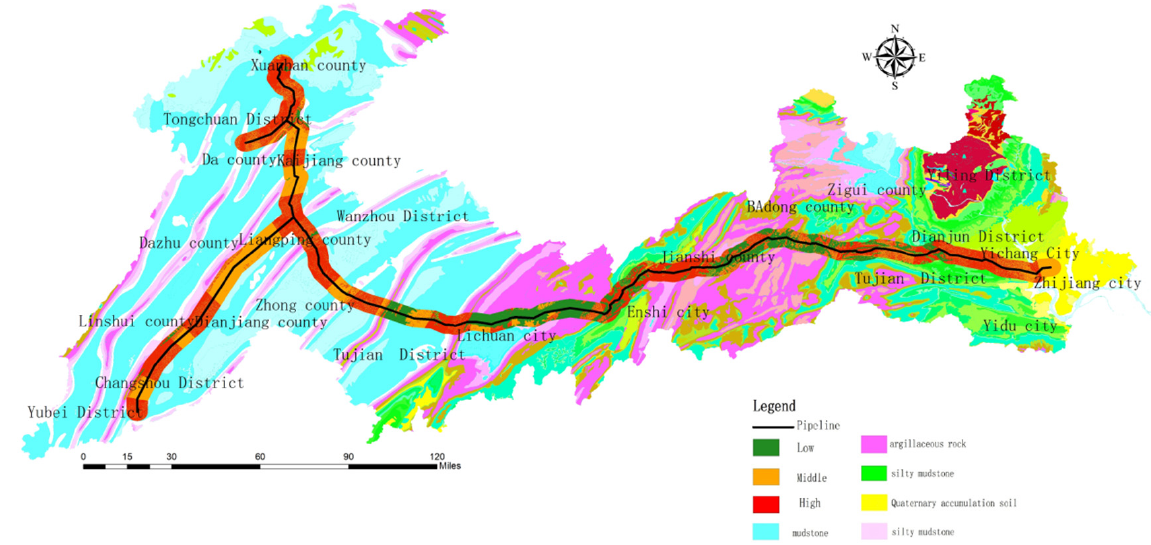
Figure 15. Hazard partition of the WOE-BP model.